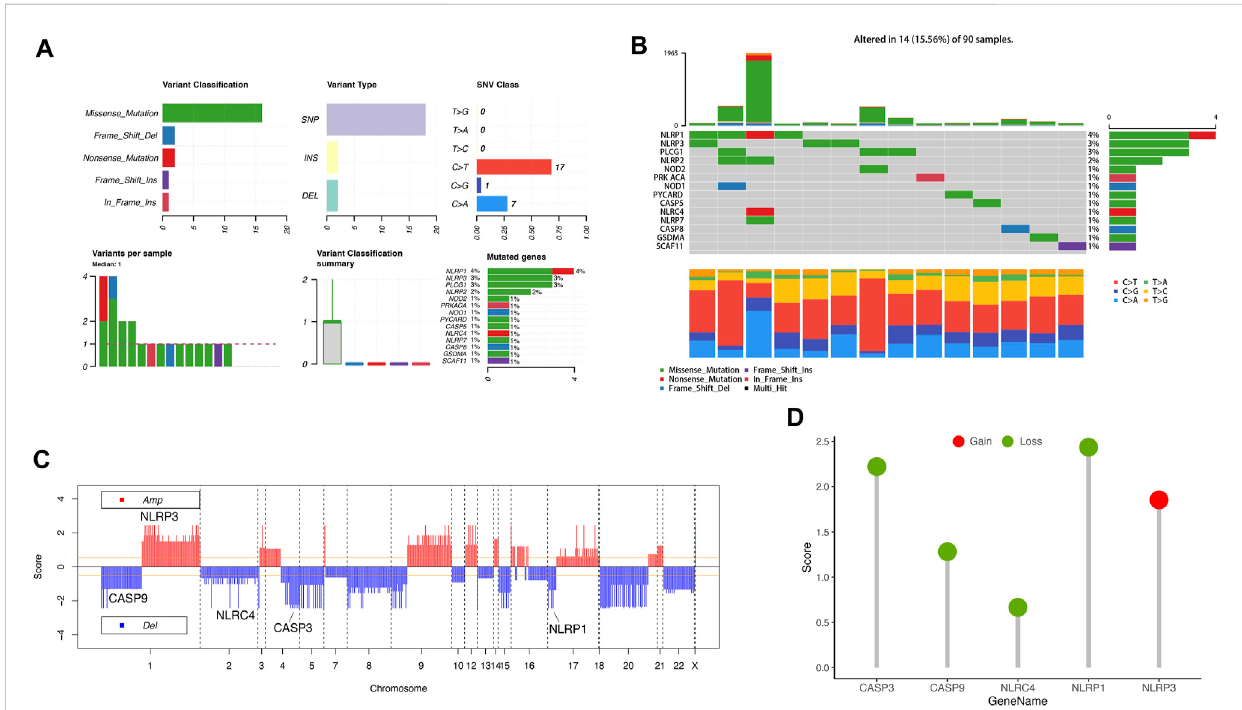
FIGURE 2 Landscape of genetic variation of PRGs in ACC. (A, B) The mutation of frequency and classi fi cation of 33 PRGs in ACC. (C) The location of CNV alteration of 33 PRGs on 23 chromosomes in the ACC cohort. (D) The CNV variation frequency of 33 PRGs in the ACC cohort. The height of the column represented the alteration